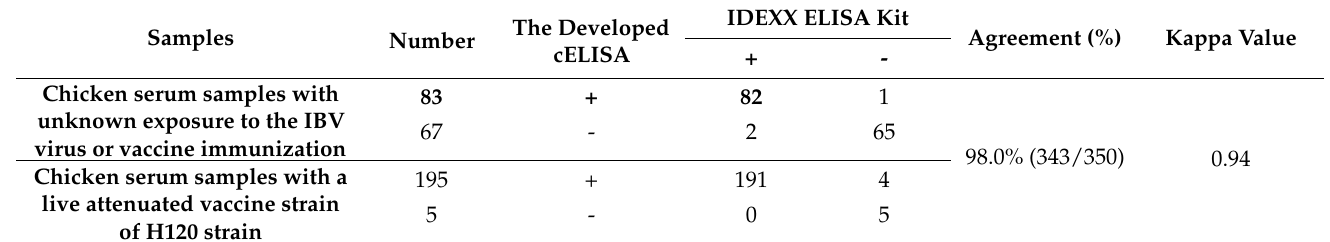
Table 4. Comparisons of the developed cELISA with IDEXX ELISA kit by detecting clinical chicken serum